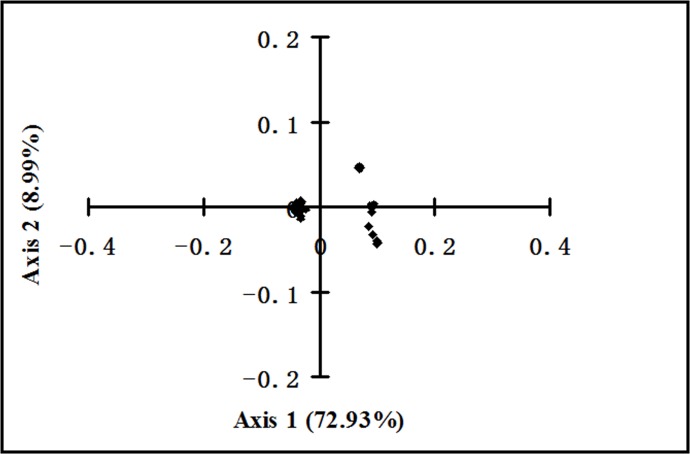
A plot of values of the first axis (Axis 1) and the second axis (Axis 2) of each polyprotein-coding region of ZIKV in correspondence analysis.The first axis accounts for 72.93% of total variation, and the second axis accounts for 8.99% of total variation.